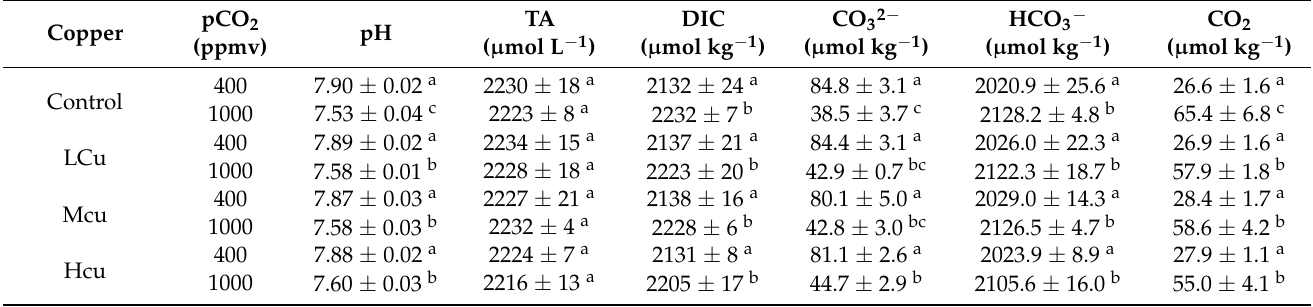
Table 1. Carbonate parameters of seawater at different pCO 2 levels and copper concentrations. C (control, natural seawater); LCu (low copper concentration, 0.2 µ M); MCu (medium copper concentration, 0.5 µ M); HCu (high copper concentration, 0.2 µ M). Data are shown as mean value ± SD